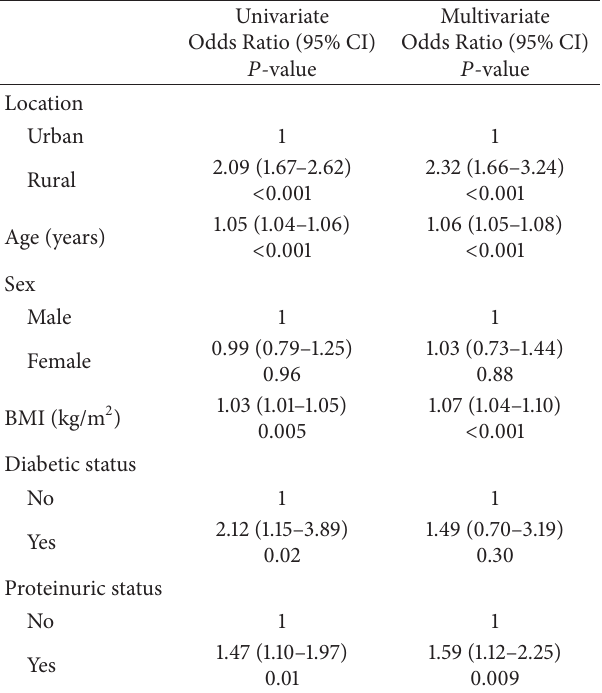
Table 3: Univariate and Multivariate ∗ regression models for hyper- tension